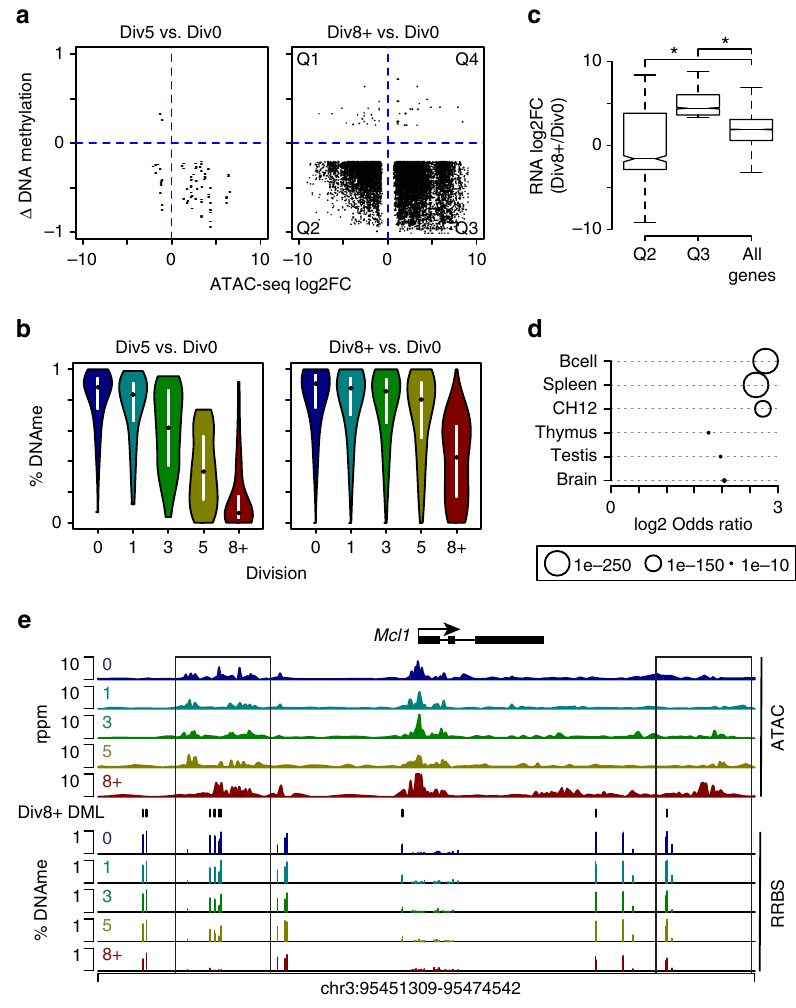
Fig. 2 Chromatin accessibility changes are associated with losses in DNA methylation. a The change in DNA methylation versus the change in chromatin accessibility for regions that overlap at the indicated division was plotted. DNA methylation data was previously reported 2 . b Violin plot describing the percent DNA methylation at each division for CpGs that are plotted in a . The mean methylation is indicated by a black dot and white lines denote s.d. c Box plot displaying the fold change in gene expression between Div8 + versus Div0 for genes that map to quadrants Q2 and Q3 from a compared to the change at all genes. Boxplot center line indicates data median, lower and upper bounds of boxes the 1st and 3rd quartile ranges, and whiskers the upper and lower ranges of the data. * P -value < 2e − 16 as determined by Wilcoxon Rank Sum test. d The odds ratio (log2 scale) for enhancers from the indicated tissue with loci that are denoted as DAR and DML in a between Div8 + versus Div0. Signi fi cance was determined by a Fisher ’ s exact test. e ATAC-seq and DNA methylation pro fi le for the Mcl1 locus is plotted. Boxed regions are B cell lineage